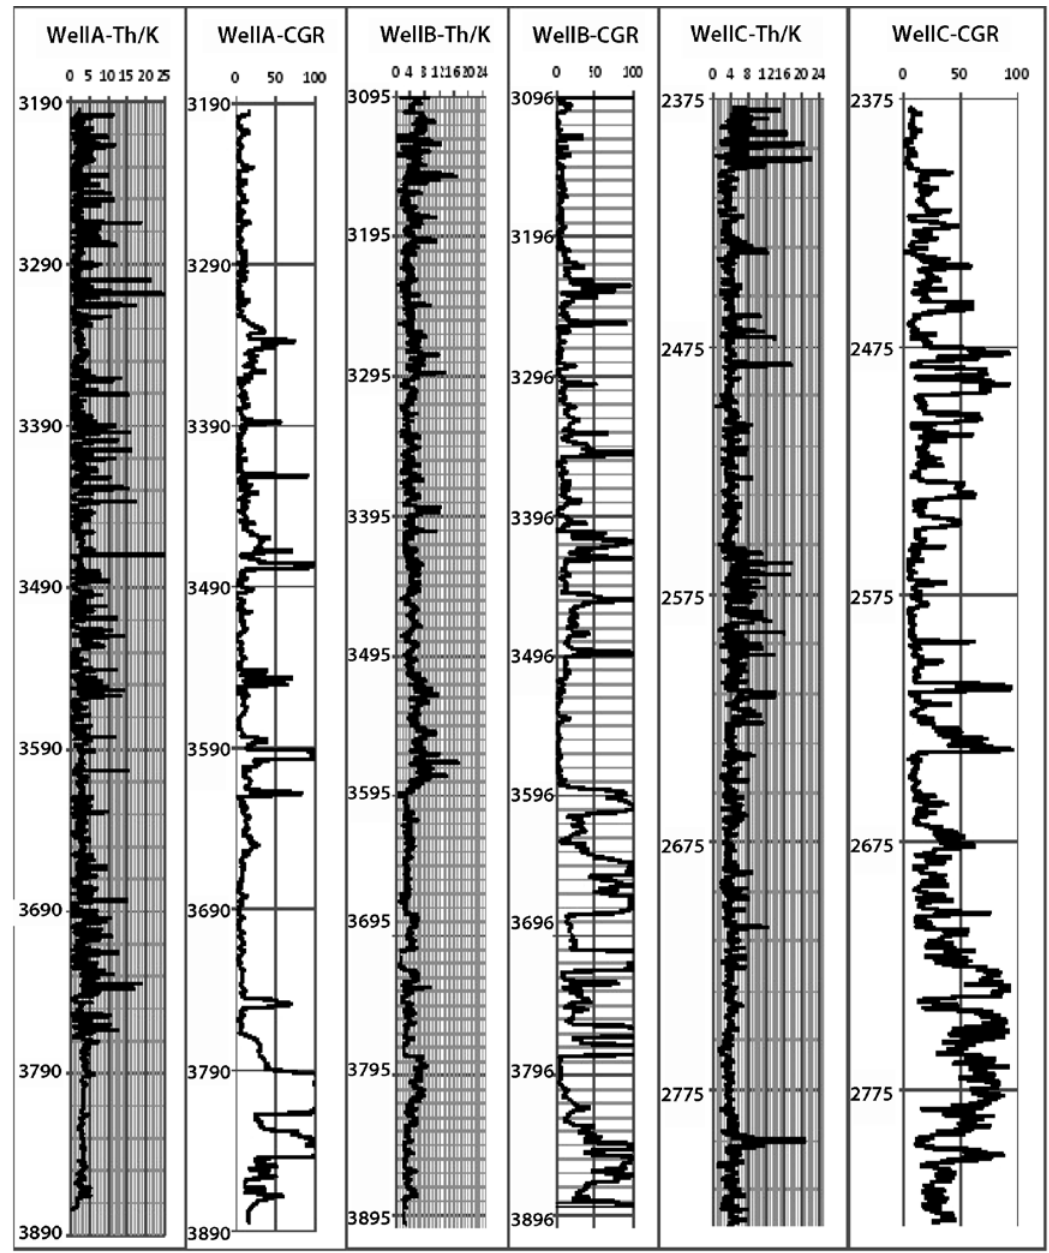
Fig. 3. Correlation of CGR logs and Th/K ratios in studied wells